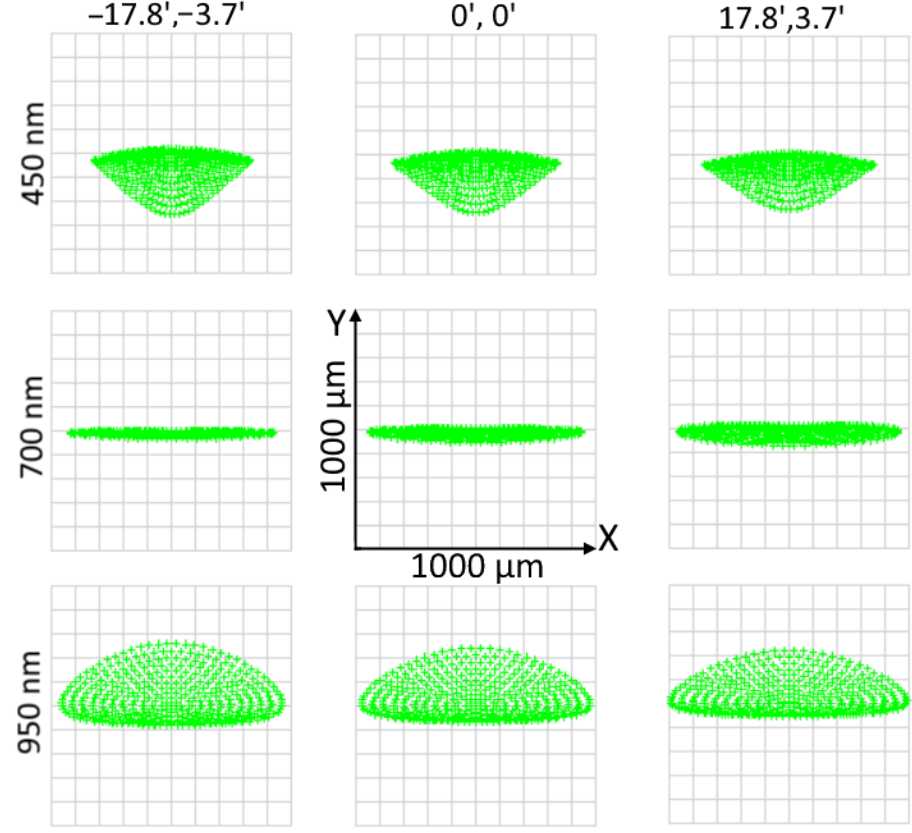
Figure 3. Spot diagrams of a spectrograph with a classical grism.